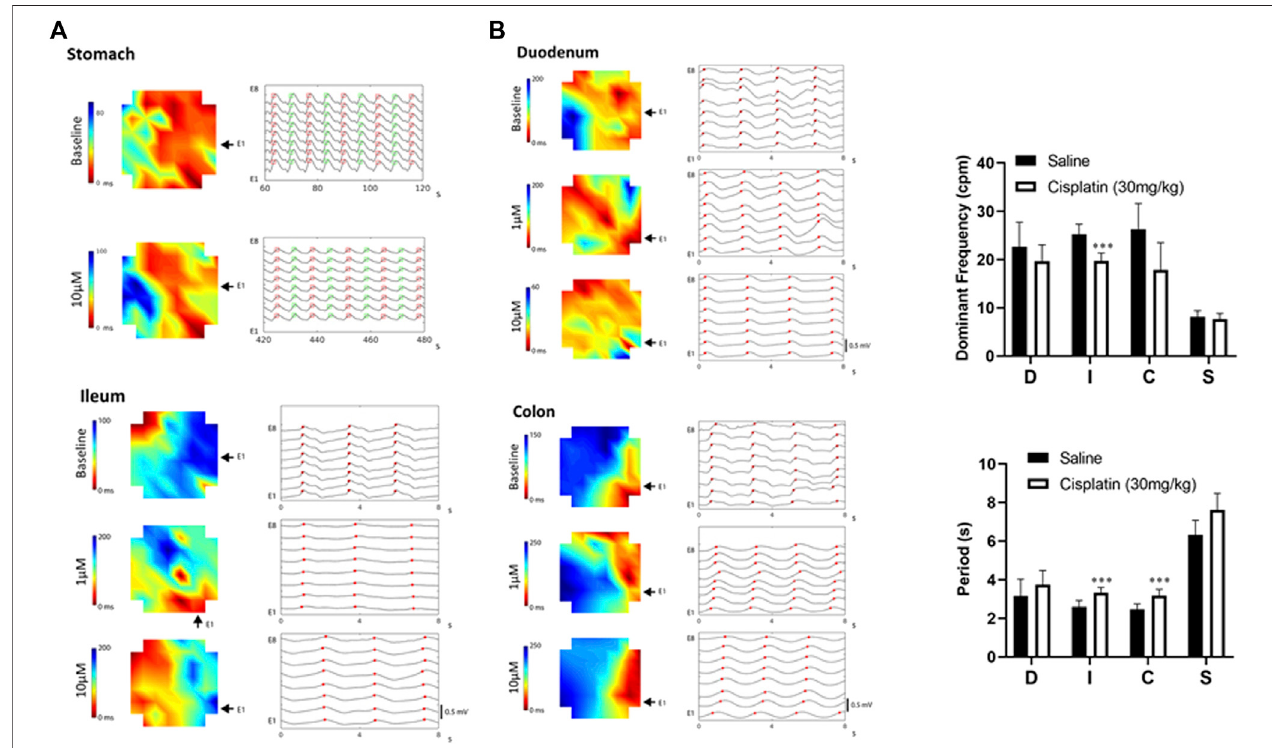
FIGURE 2 | (A) Diagram showing representative activation maps indicating the spread of slow waves (red to blue) over time. Propagation became faster in the duodenum, but became slower in the colon or stomach following cisplatin (1 – 10 μ M). The samepeak events are labelled with red dots (plus green dots in stomach) and alignedverticallyandseparatedbytimeacrossahorizontal/verticalarrayofeightelectrodes.Therawtracesofthestomachrepresent60 sofdata,whiletherawtracesof the duodenum, ileum and colon represent 8 s of data. (B) In vivo effects of cisplatin treatment (30 mg/kg, i.p.) at 90 min. Slow-wave signals were measured using microelectrode arraytechniques.Dataaremeans ± standarddeviations. Signi fi cantdifferencesrelative tothebaselineareindicatedas*** p < 0.001(unpaired t -tests).D: duodenum; I, ileum; C, colon; S, stomach.